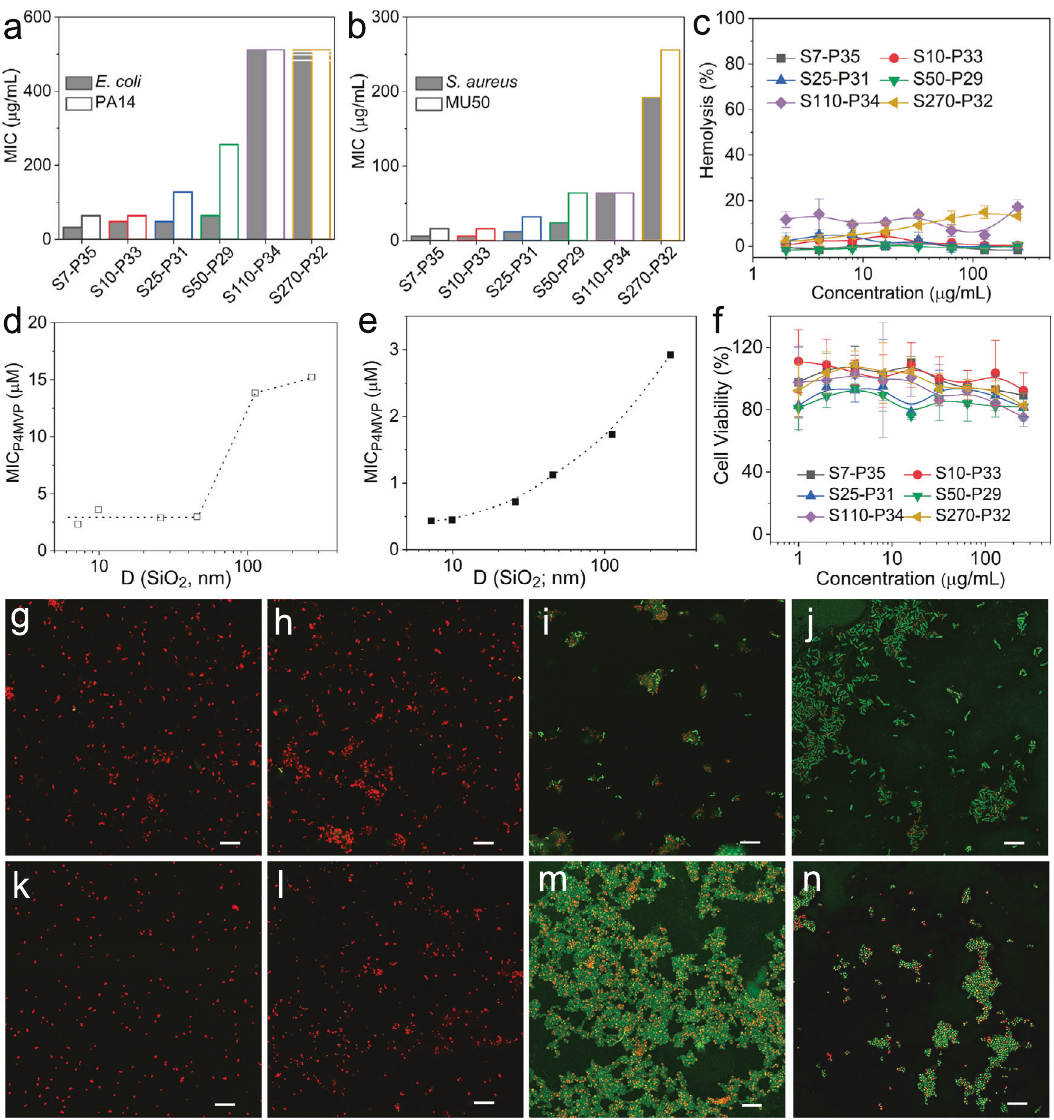
Fig. 2 The biological activities of model NPPBs. Although the hydrophilic NPPBs show no HC 50 against HRBCs ( c ) nor IC 50 against HEK-293 cells ( f ) (Error bars = Standard Deviation ( n = 8) in both c and f ), they show nanoparticle-size dependent bacteriostatic activities against a Gram − E. coli and PA14 , and b Gram + S. aureus and MU50 . This nanostructure-induced transformation of antimicrobial activity intensi fi es with smaller NPPBs ( d silica ≤ 50 nm) but subsides quickly with larger ones ( d silica > 50 nm). The same nanoparticle-size dependency is further revealed when the MICs are normalized to P4MVP brush concentration for NPPBs of different sizes and speci fi c surface areas as shown in d Gram − E. coli , and e Gram + S. aureus , respectively. The bactericidal activities of model NPPBs follow a similar nanoparticle-size dependency (Supplementary Fig. 10), which is on clear display under confocal microscope by live/dead assays of E. coli ( g – j ) and S. aureus ( k – n ) incubated with S10 – P33 ( g , k ), S25 – P31 ( h , l ), S110 – P34 ( i , m ), and S270 – P32 ( j , n ) at the same NPPB concentration of 32 μ g/mL (Scale bar: 10 μ m). Similar snapshots demonstrating the nanoparticle-size dependent bactericidal activities as shown in g – n are consistent across all confocal microscopy pictures of individual samples taken in different experiments ( n =